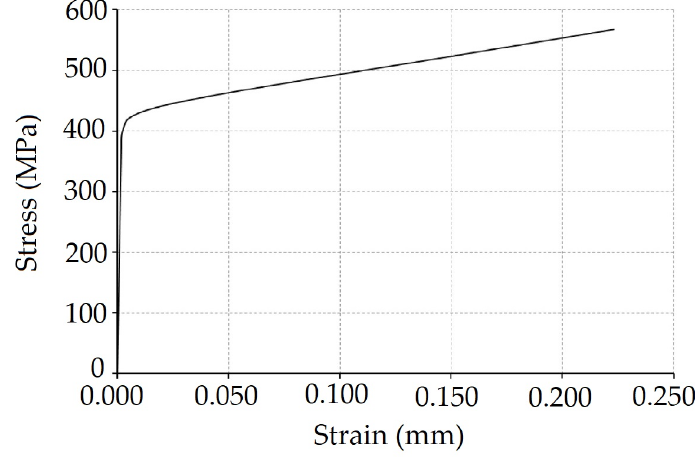
Figure 14. Steel stress–strain curve.